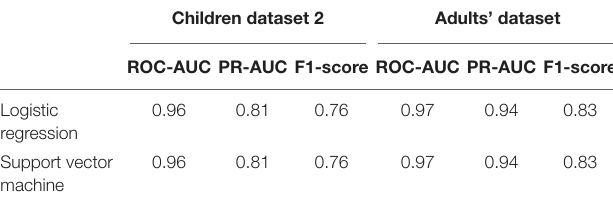
TABLE 6 | Performance rate on additional